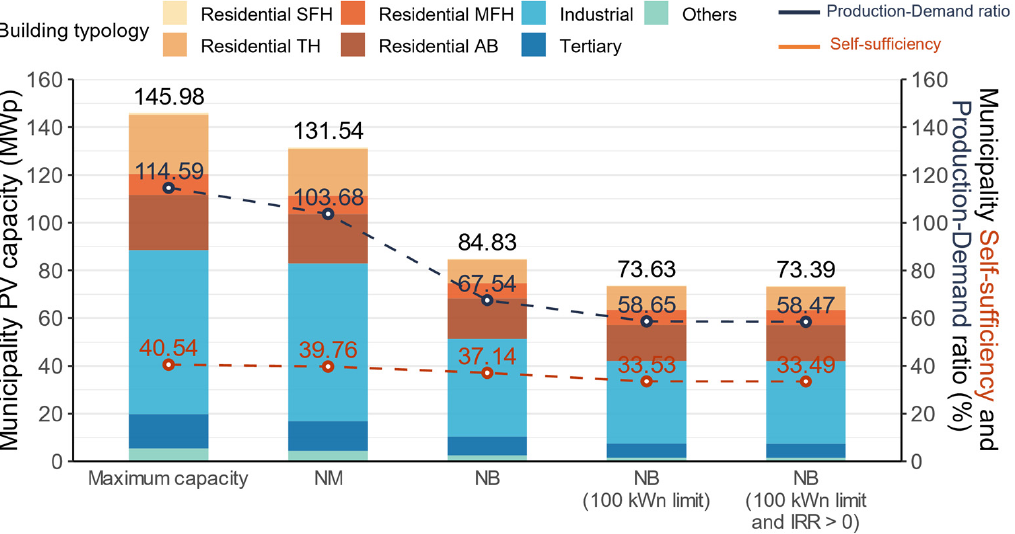
Figure 7. Comparison of aggregated capacities, self-sufficiencies and production-demand ratio for the complete municipality.